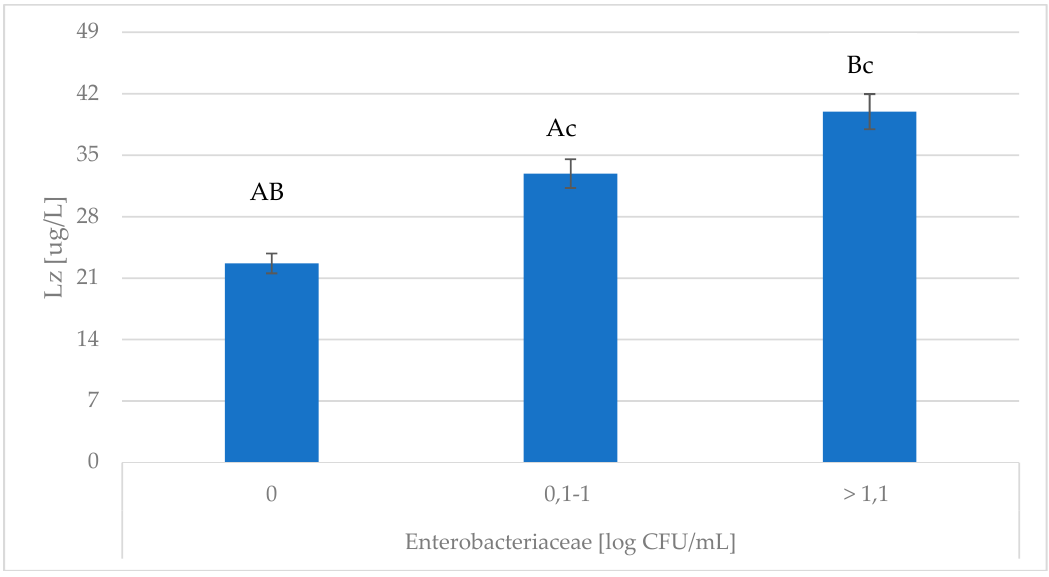
Figure 1. Association of Enterobacteriaceae with changes in Lz content. Lz—lysozyme; A,B,c Means with the same letters differ significantly at: small letters— p ≤ 0.05; capitals— p ≤ 0.01.